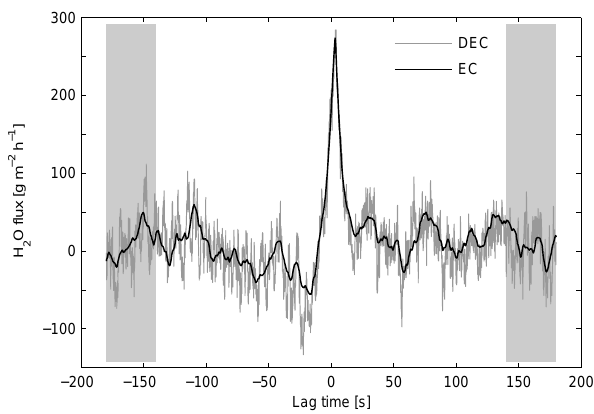
Fig. 3. Principles of the lag time methods illustrated with a covari- ance function of M137 (11 August 2007 12:00–12:45). The calcu- lated (CALC) and typical (TYP) constant lag times were 7.1 and 9.9s. In the maximum covariance method (MAX), the lag time was 10.5s. The averaging approach (AVG) yielded a lag time of 11.7s, which was determined from the maximum of the averaged covari- ance function. However, the final flux value was derived from the original covariance function. The visual assessment method (VIS) gave a lag time of